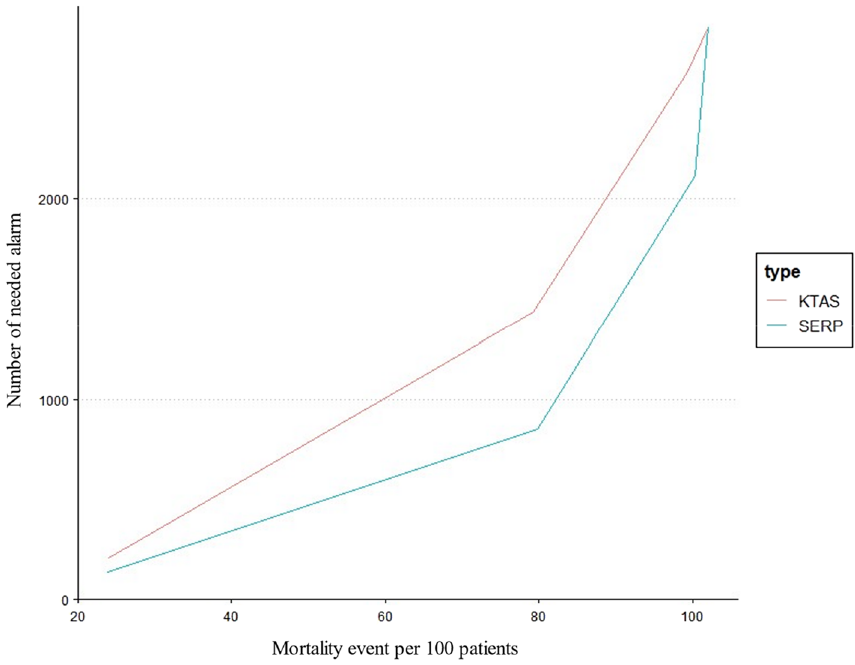
Figure 2. Comparison of the number of needed alarms at the same sensitivity point for predicting mortality between KTAS (Korean Triage Acuity Scale) and SERP (Score for Emergency Risk